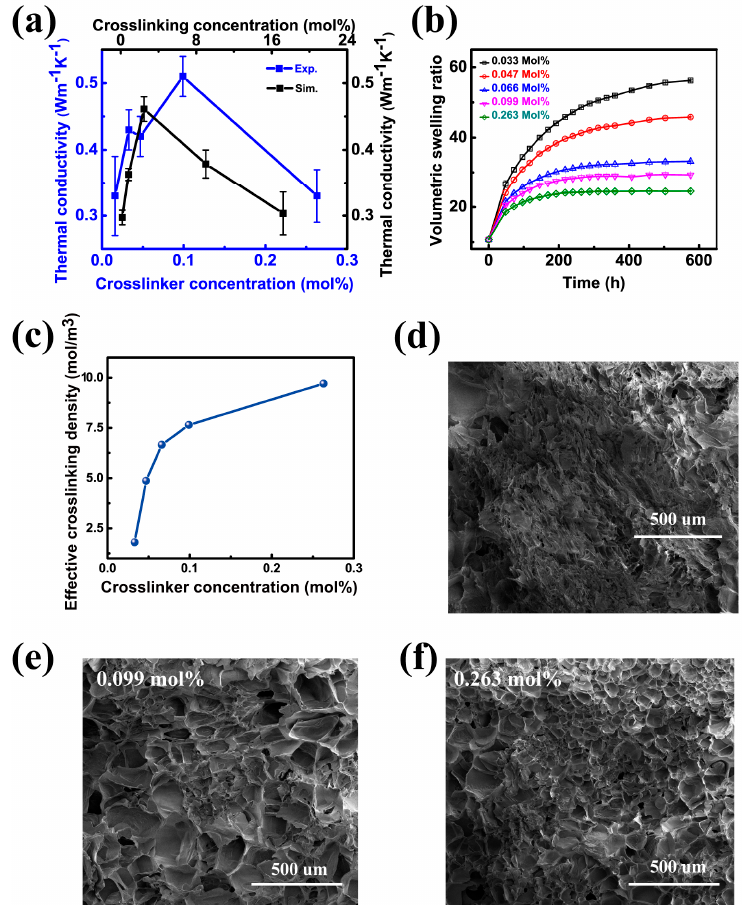
Figure 2. Crosslinking effect of PAAm hydrogels. ( a ) Experimental and simulation results on the thermal conductivity of PAAm hydrogels with different crosslinker concentrations. The blue curves are the experimentally measured thermal conductivities by the 3 ω method, and the black curves are the simulated thermal conductivities by molecular dynamics simulations; ( b ) The volumetric swelling ratio of PAAm hydrogels as a function of swelling time; ( c ) The relationship of the effective crosslinking density, and the corresponding crosslinker concentration. SEM images of PAAm gels of constant monomer concentrations and different stages of cross-linking; ( d ) 0.033 mol %; ( e ) 0.099 mol %; ( f ) 0.263 mol %.